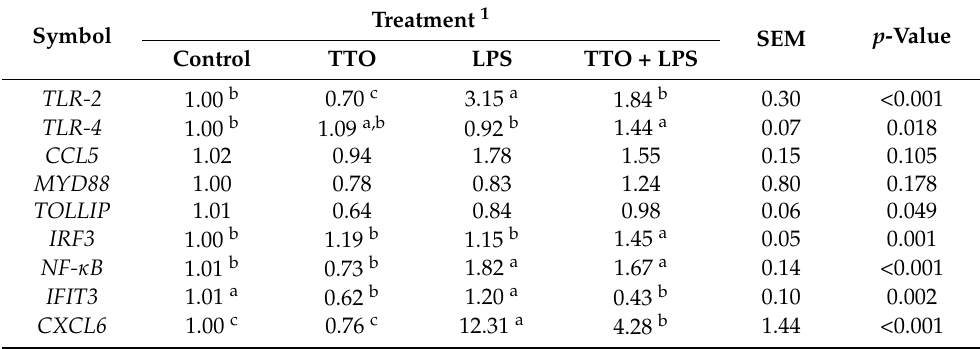
Table 2. Expression of inflammatory regulatory genes in control, TTO, LPS and TTO + LPS groups in in vitro incubated goat rumen epithelial cells.